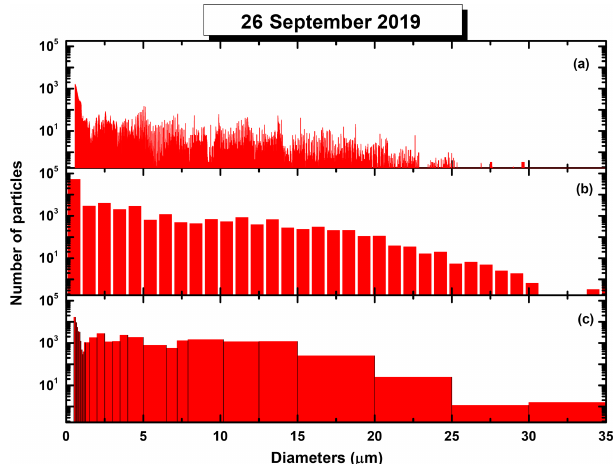
Figure 4. Droplet size distribution of Fig. 3a and b (panels a and b , respectively) shown in comparison with the size distribution of the same droplets constructed over the 30-bin structure used for the in-flight data